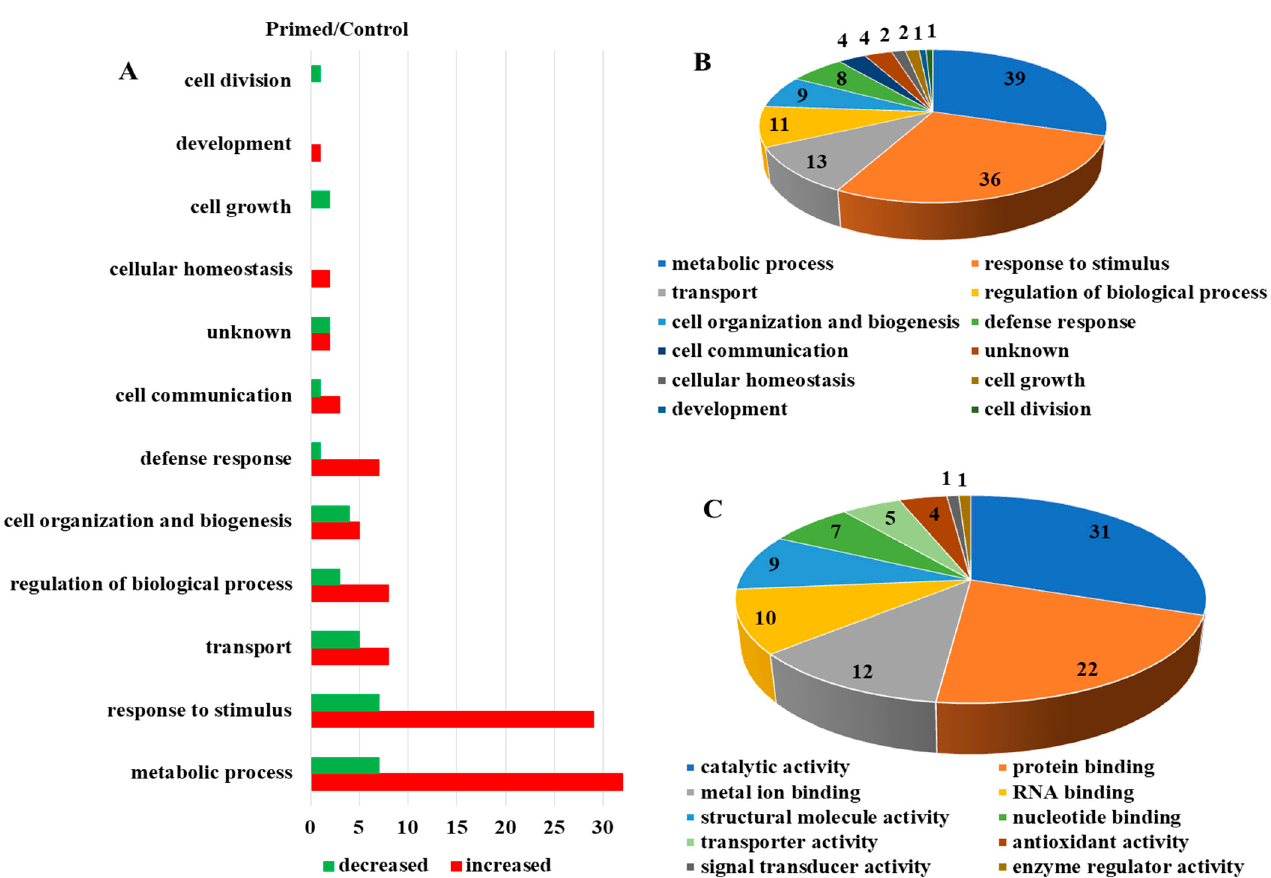
Figure 3. Dynamic protein changes in primed guard cells and functional classification. ( A ) Numbers of proteins with altered abundances in primed Arabidopsis guard cells categorized by biological function. ( B ) Biological processes of the identified guard cell proteins. ( C ) Molecular functions of identified guard cell proteins.